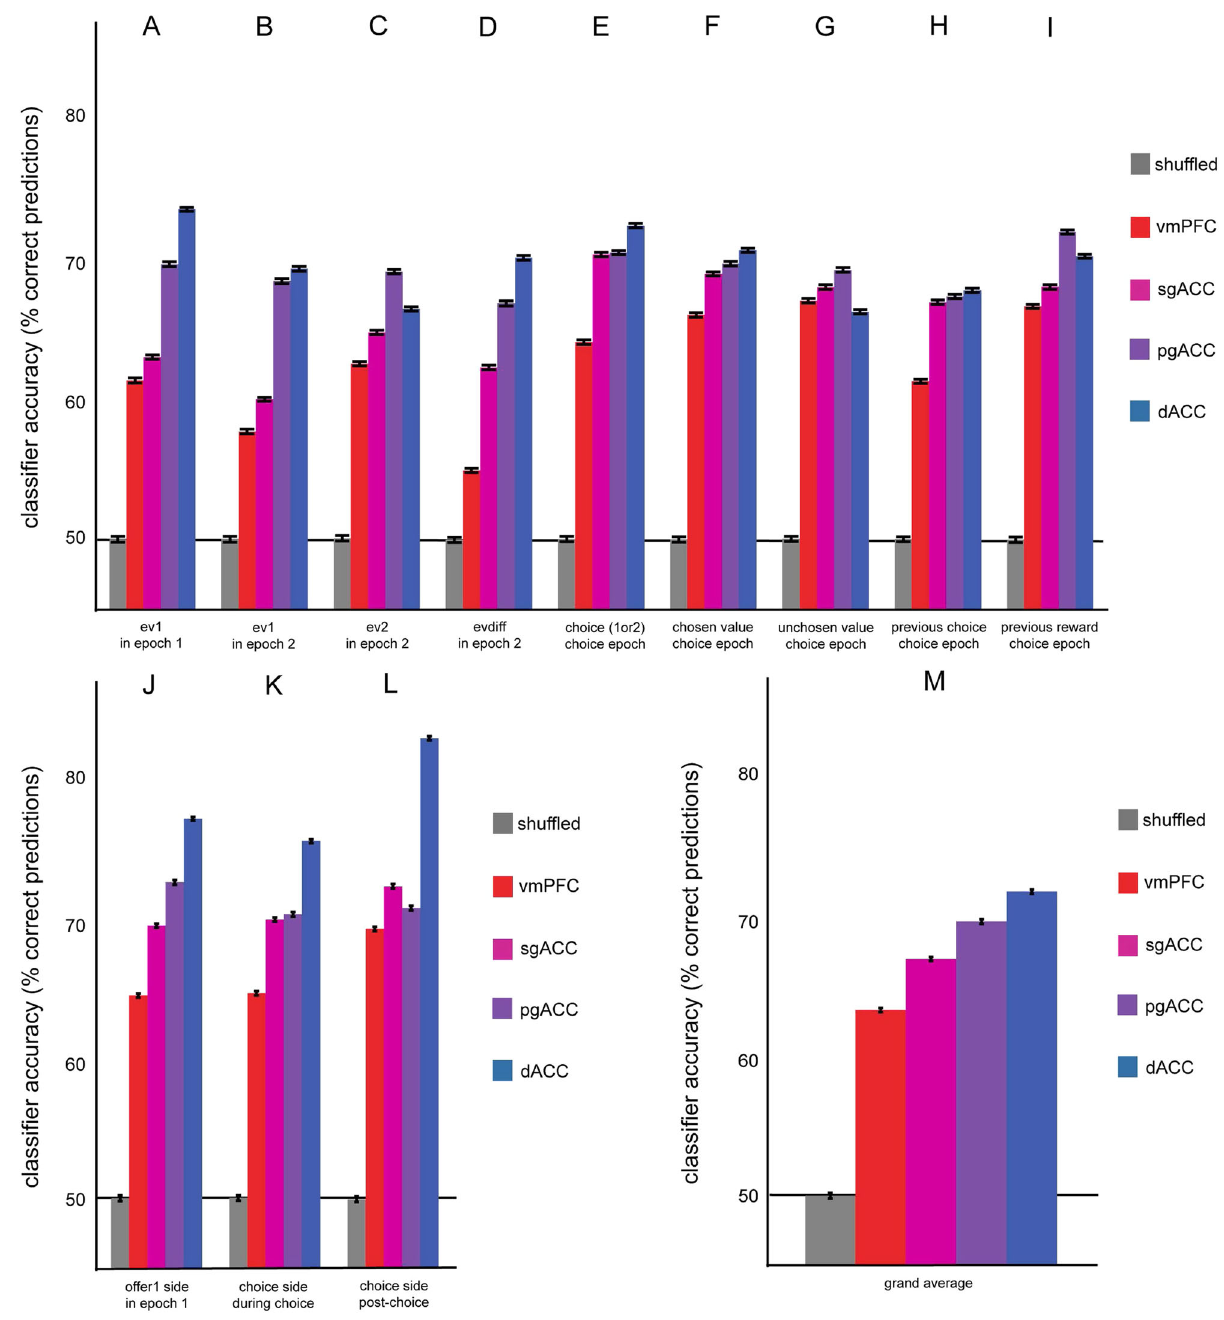
Fig. 6 Decoding analysis. A – M Summary of classi fi cation accuracies for each of the given labels (red = vmPFC, pink = sgACC, purple = pgACC, blue = dACC; n = 1000 bootstrapped samples). Bars plot the average decoding accuracy across cross-validation iterations. In a given epoch, a linear classi fi er was trained to identify the value of a binary label (indicated on the x -axis). The accuracy of the trained model was tested by cross-validation to predict the label value on untrained data (permutation average indicated on the y -axis). The accuracy of a model trained on randomly shuf fl ed data is indicated by the gray bar. Error bars represent the standard error over the variance across cross-validations. Source data are provided as a Source Data fi